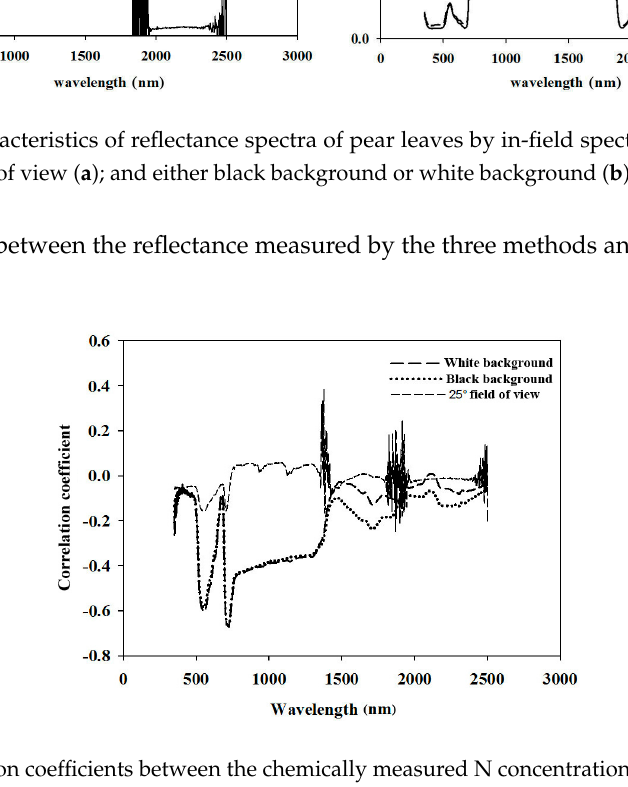
Figure 3. Correlation coefficients between the chemically measured N concentration in pear leaves and reflectance measured by the three methods. Table 2. Modelling results using four chemometric methods with two spectral datasets as measured by black or white backgrounds.